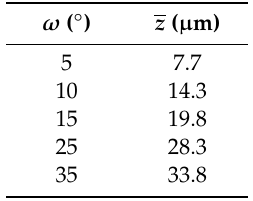
Table 4. Cu-K α e ff ective penetration depths for Mg alloys, corresponding to di ff erent incident angles, calculated from Equation